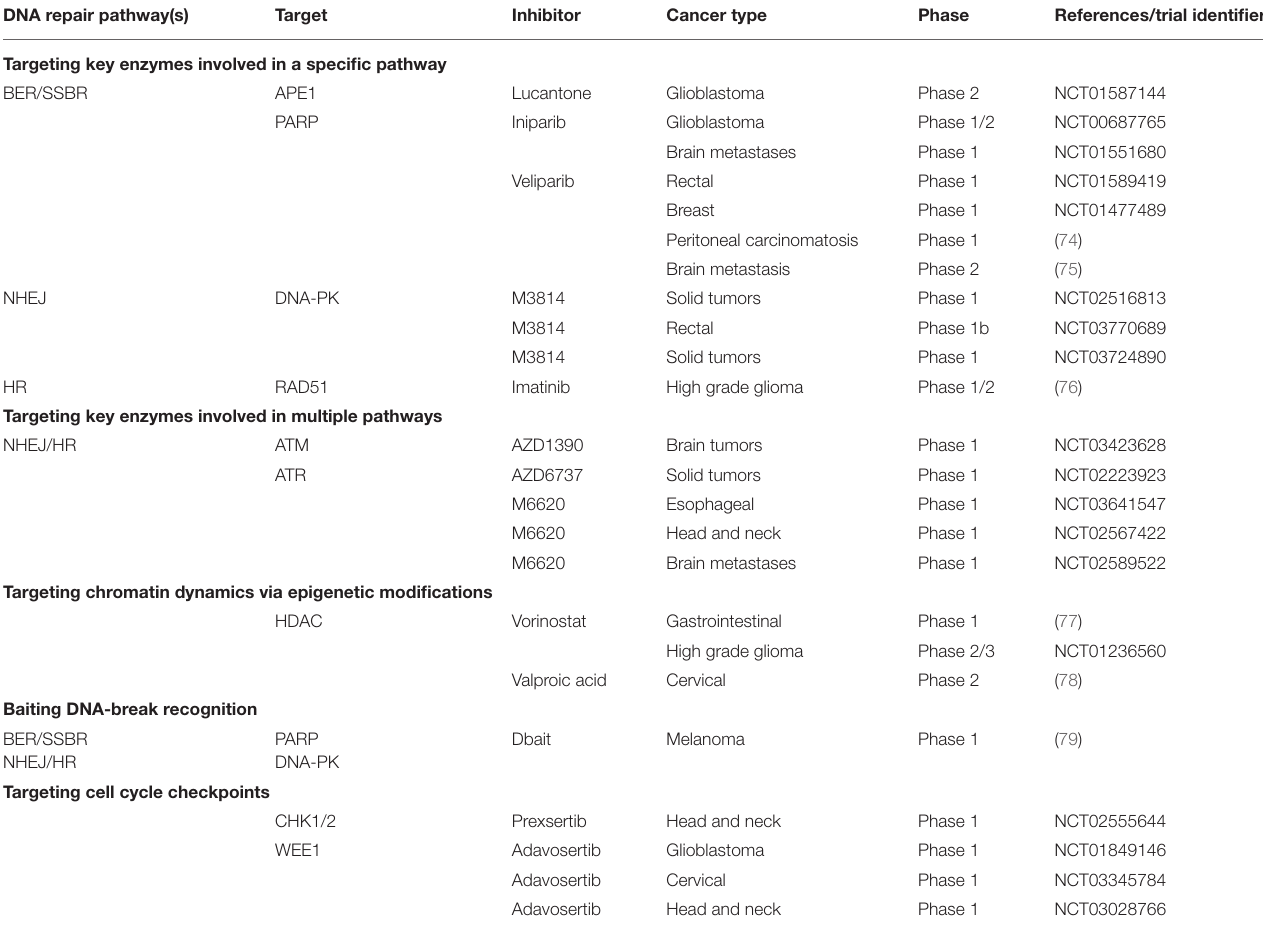
TABLE 1 | Examples of clinical trials of inhibitors of the DNA damage response in combination with radiation therapy. DNA repair